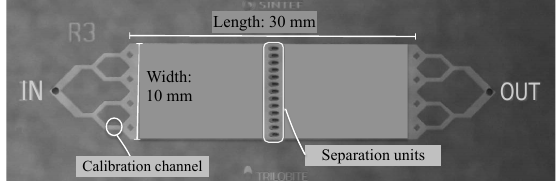
Figure 5. Microfluidic chip: the feed flow enters through the inlet, “IN” and flows from left to right through branching channels and a main channel (10 mm wide and 30 mm long) at a flow rate of Q in . An array of filter units, 13 in total, serve to separate the permeate flow (flow rate Q p ) from the concentrate flow (flow rate Q c ). The concentrate exits through the downstream outlet, “OUT”, while the permeate exits through an outlet directly below the separation units. The total flow rate, Q in , and the concentration ratio, Q p / Q c , are monitored by weighing the permeate and concentrate